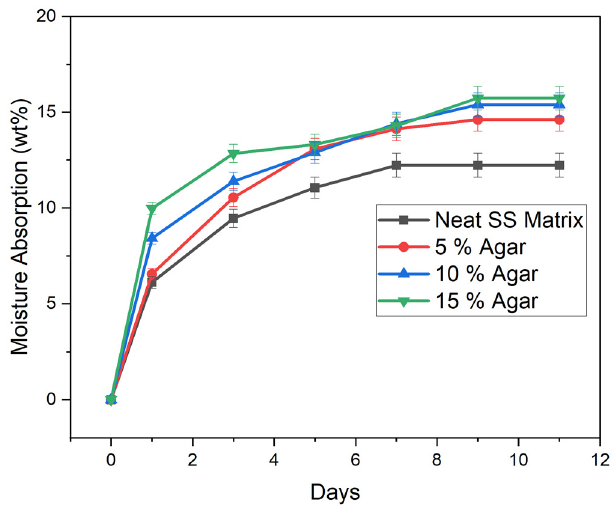
Figure 8. Moisture absorption behaviour of TPSS (neat SS matrix) with different amounts of agar.